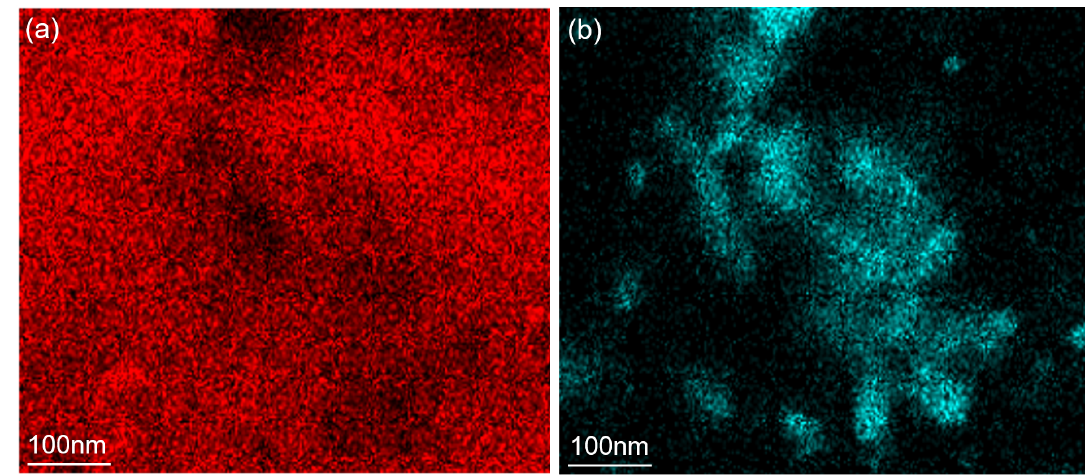
Figure 6: EDS images of modified phenolic resin film with 4% nano-silica (a) Element C and (b) Element